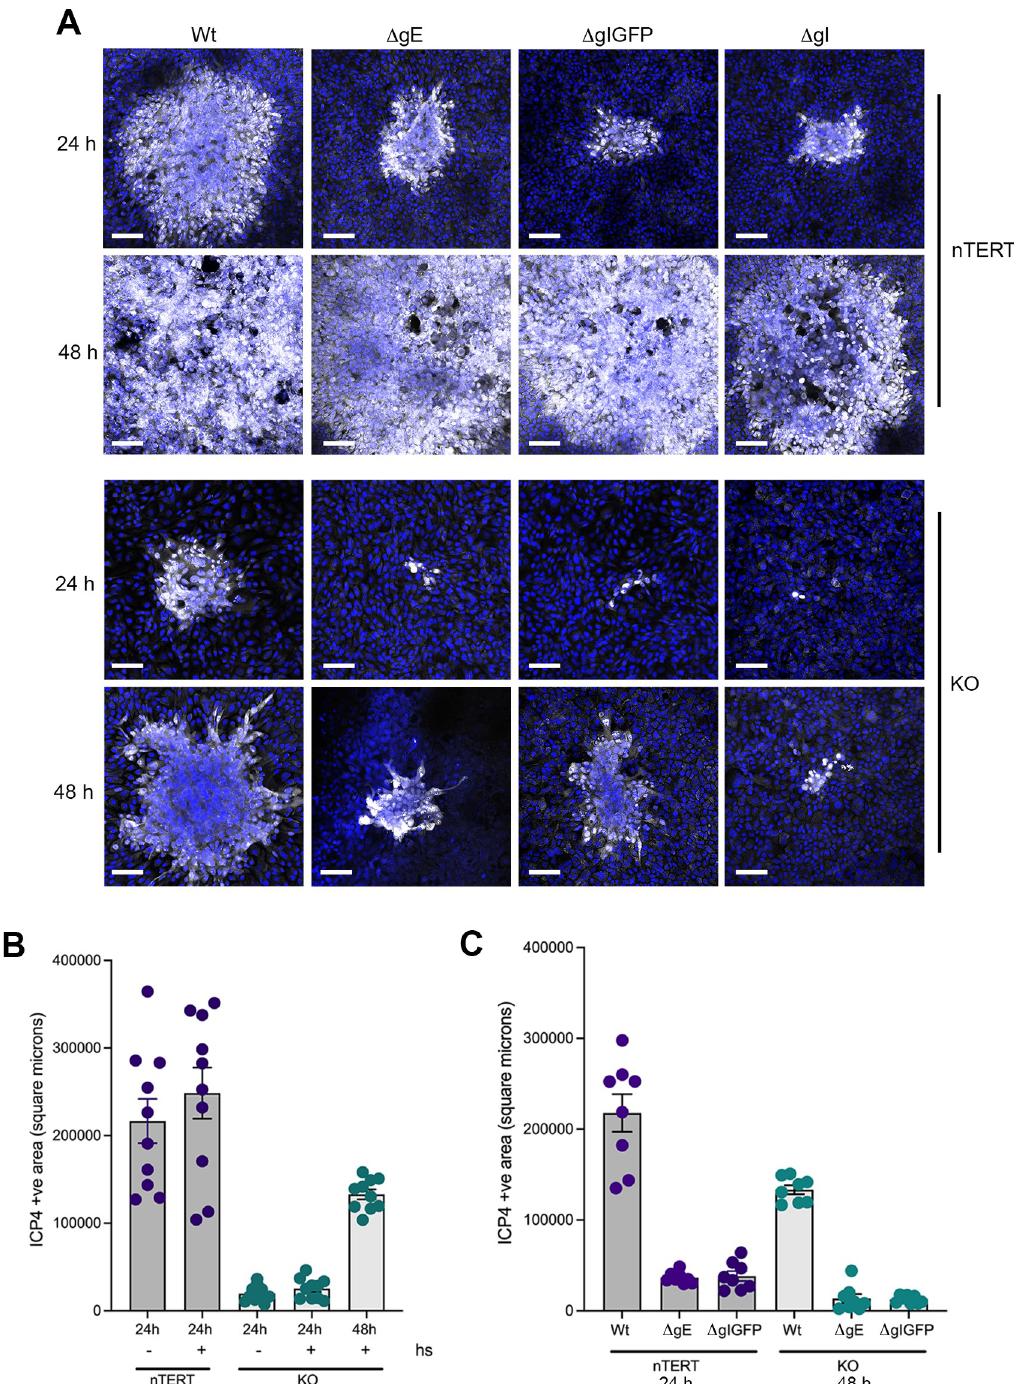
Fig 10. HSV1 spreads via cell-to-cell transmission in the absence of nectin1. (A) nTERT and KO cells grown on coverslips were infected with 50 or 2000 plaque forming units (calculated on Vero cells) respectively of HSV1 viruses as indicated in the presence of 10% human serum to neutralise extracellular virus and block extracellular spread. Cells were fixed at the indicated times, stained for ICP4 (white) and nuclei stained with DAPI (blue). Scale bar = 100 μ m. (B) The area of ten ICP4-positive Wt foci on nTERT and KO cells infected in the absence or presence of human serum (hs) was measured using NIH ImageJ . (C) The area of eight ICP4-positive foci of Wt, Δ gE and Δ gIGFP viruses on nTERT and KO cells infected in the presence of human serum (hs) was measured using NIH